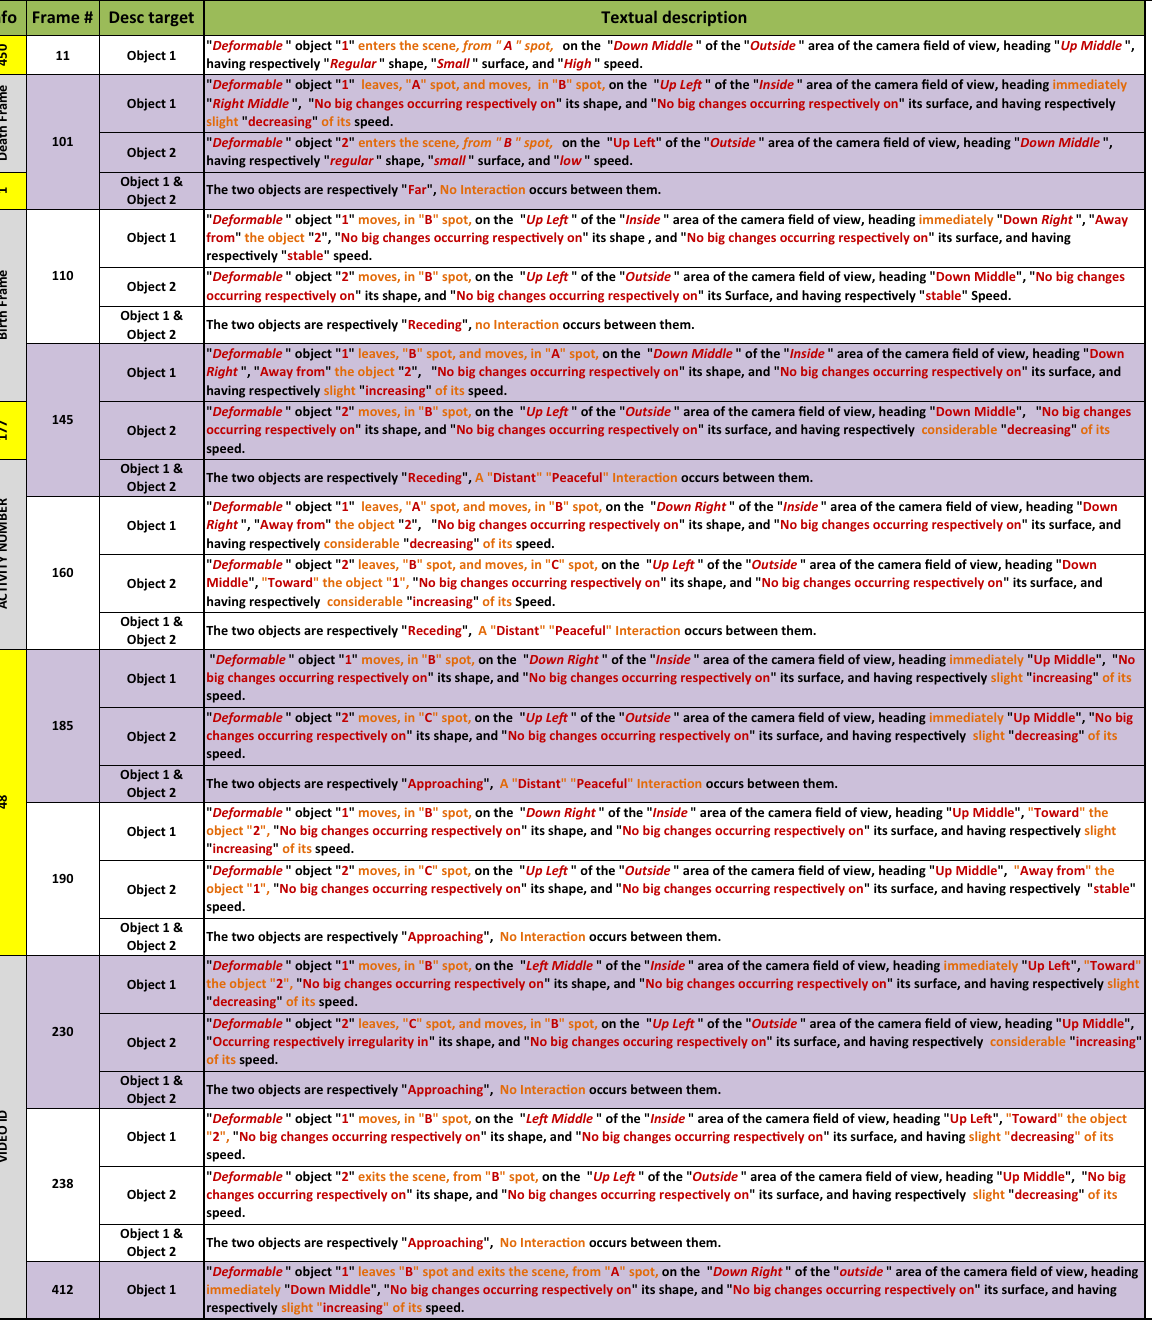
Table 8 The full description of the scene "LeftBox"[24], results of map- ping matrix A into our proposed templates. At each key moment, cor- responding to one of the irregularities mentioned in the description